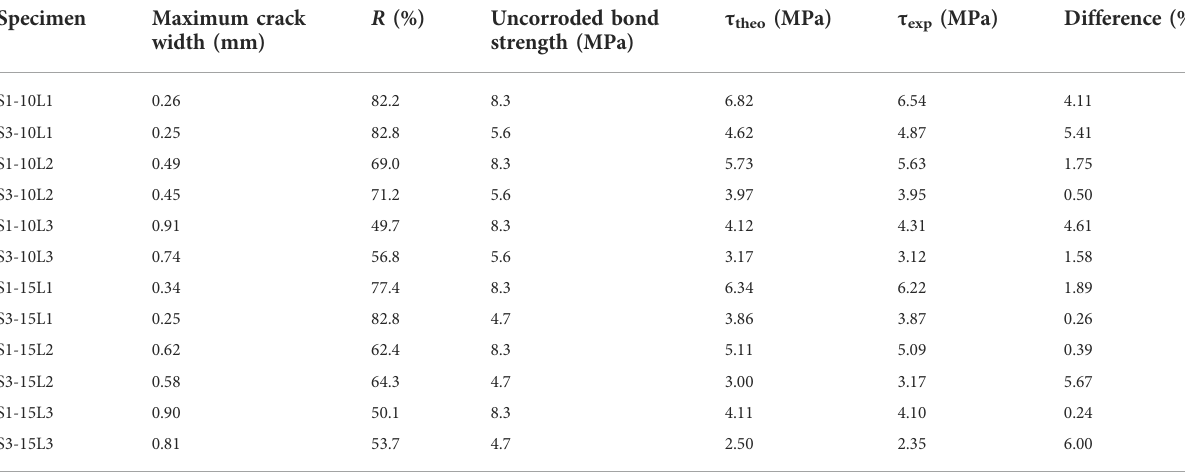
TABLE 7 Validation of the proposed model based on maximum crack width.